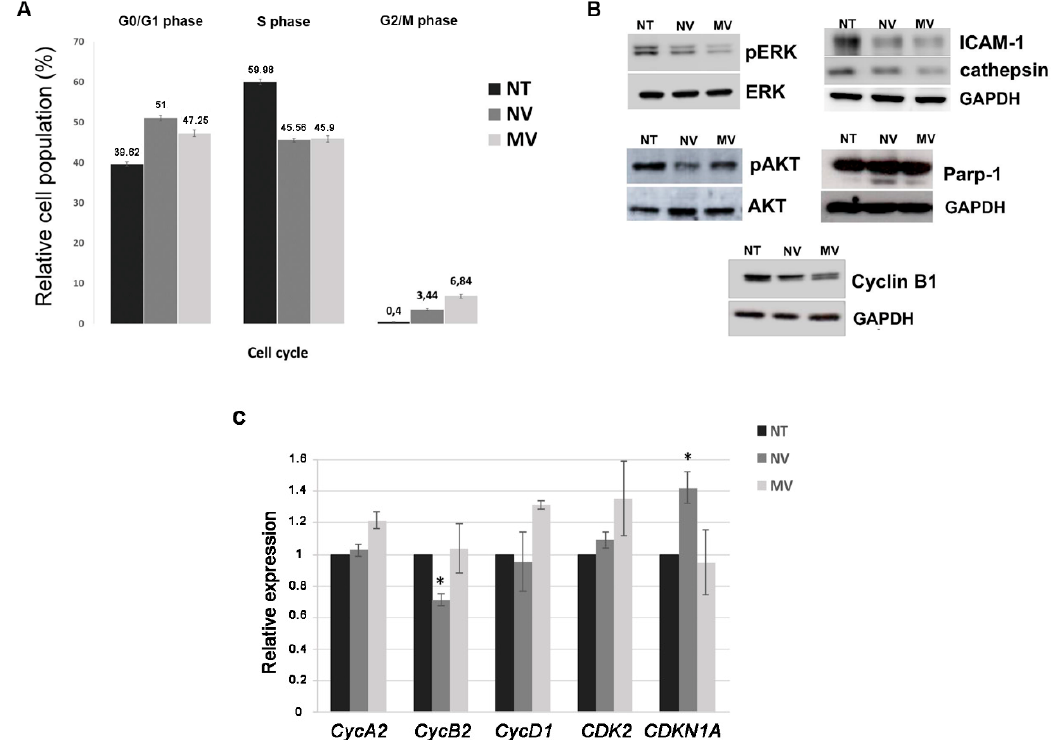
Figure 2. Grapefruit-derived vesicles induce cell cycle arrest and affect the expression of oncogenes and cell-cycle regulatory genes in melanoma cells ( A ) Flow cytometry analysis of melanoma A375 cells untreated (NT) or treated with 25 μ g/mL nanovesicles (NVs) or microvesicles (MVs) for 24 h. Cell distribution in the different cell cycle phases was determined by propidium iodide staining. Each point represents the mean ± SD of three independent experiments. ( B ) Western blot analyses were performed on cells treated for 24 h with 25 μ g/mL of C. paradisi -derived nanovesicles or microvesicles. Levels of proteins involved in cell proliferation (pERK and pAkt), oncogenes (ICAM 1 and cathepsin) and apoptosis (Parp-1) were evaluated. Blots were stripped and subsequently re-probed with an antibody against GAPDH to check equal loading of protein extracts. ( C ) Relative expression levels of cell-cycle regulatory genes in 24 h NV- and MV-treated melanoma cells by qRT-PCR. GAPDH was used as a reference gene to normalize the expression levels. Data represent mean ± SD of three technical repeats from three biological replicates, expressed as relative fold changes compared to their basal level in untreated A375 cells. Statistically significant values in untreated A375 cells assessed by t-test (* p ≤ 0.05).